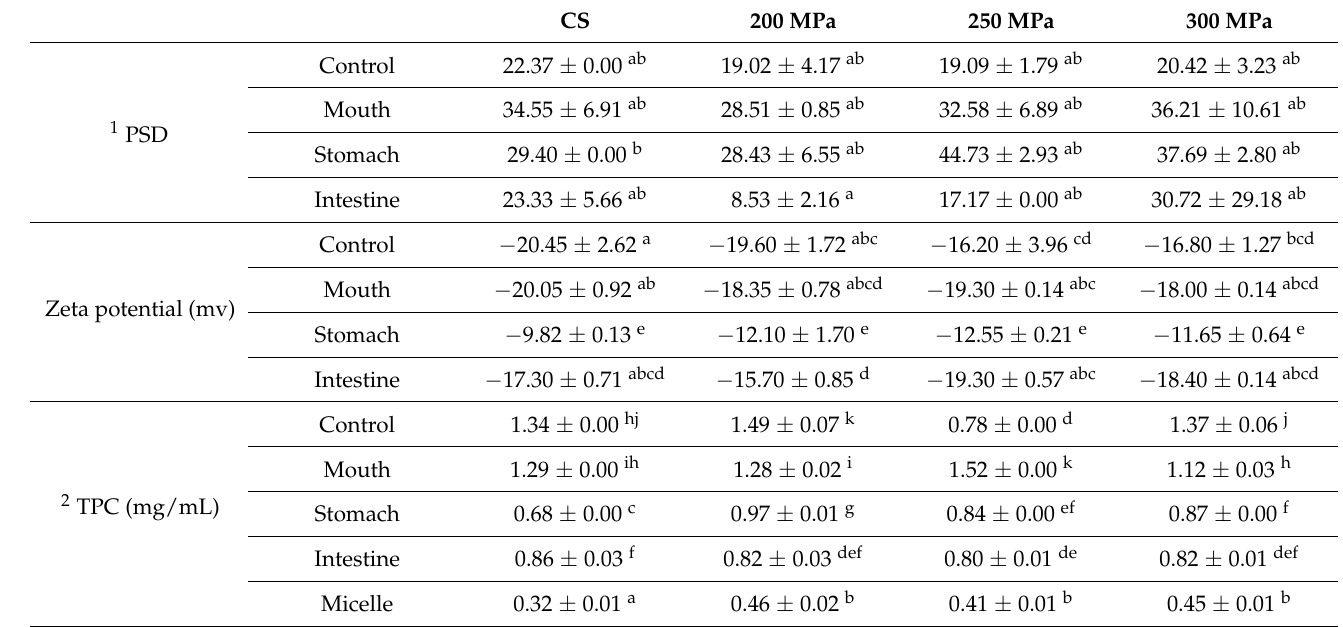
Table 3. The PSD, zeta potential, and TPC of apple juice treated using HPH treatment during simulated digestion. CS 200 MPa 250 MPa 300